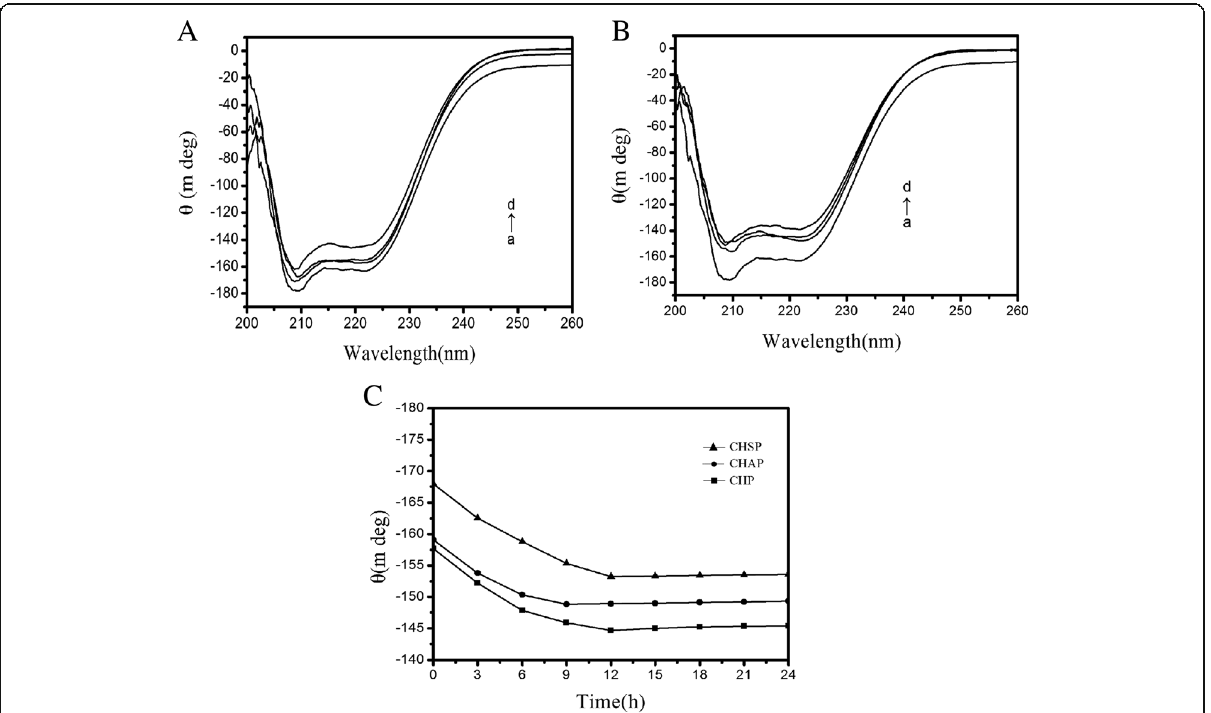
Fig. 8 A CD spectra for (a) free HSA, (b) CHSP – HSA, (c) CHAP – HSA, and (d) CHP – HSA in solution at 25 °C. The samples were complex I. B CD spectra for (a) free HSA, (b) CHSP – HSA, (c) CHAP – HSA, and (d) CHP – HSA in solution at 25 °C. The samples were complex II. C Ellipticity at 208 nm for HSA interacting with CHSP ( – ▲ – ), CHAP ( – ● – ) and CHP ( – ■ – ) over time